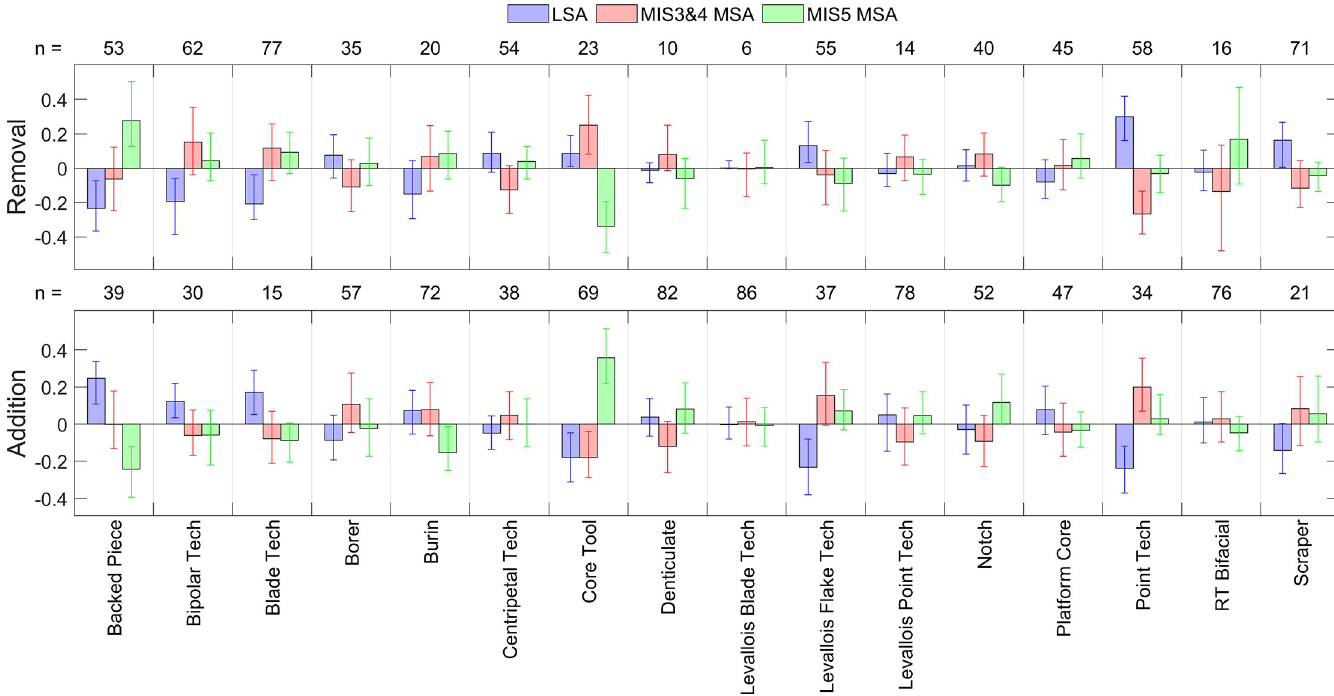
Fig 9. Delta values (3-way). Plots of delta values for the 16 technologies via the bootstrap procedure in the 3-way analysis. Positive values in the ‘Removal’ graph indicate that removing a given technology increases the probability of classification to a given period / industry. Positive values in the ‘Addition’ graph indicate that adding a given technology increases the probability of classification to a given period / industry. Error bars are 2.5 and 97.5 percentiles.